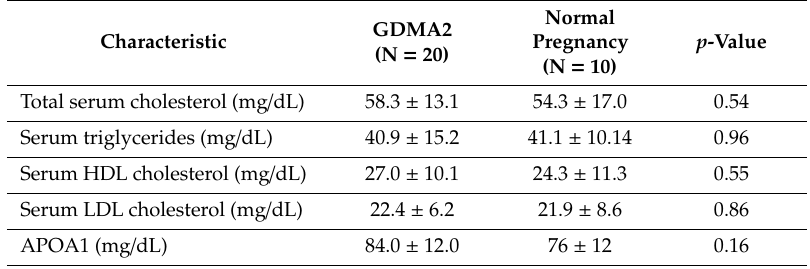
Table 2. Lipid profile of umbilical cord blood from o ff spring of women with gestational diabetes mellitus type 2 (GDMA2) and from normal pregnancies.